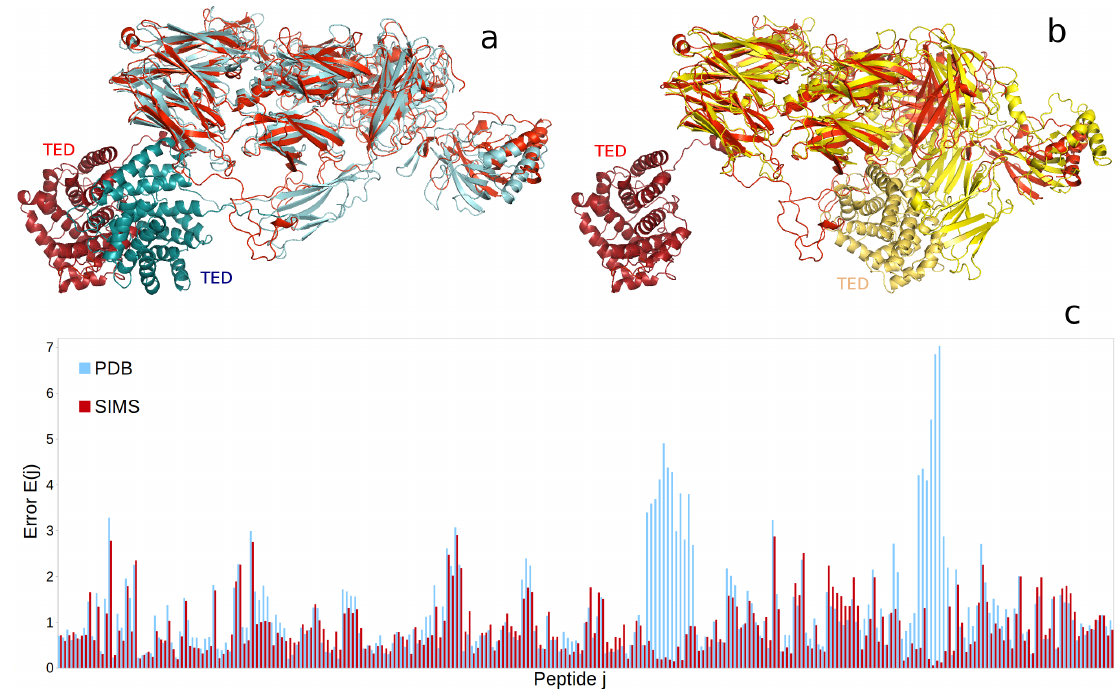
Figure 3. Uncovering the conformation of the complement protein iC3b. ( a ) Comparison between the conformation of iC3b produced by SIMS (colored red) and the hypothetical model built using the crystal structure of C3b reported in the PDB (ID 2I07, colored blue). In both conformations, the thioester-containing domain (TED), at the bottom left (colored in darker shades), is far from the protein’s core, ( b ) The conformation of C3 (PDB ID 2A73, colored yellow) is more compact, and the TED (colored dark yellow) is close to the protein’s core. ( c ) Differences between structurally-derived and experimental hydrogen-exchange data (unitless error E ( j ) , for each peptide j ) are significantly lower when these data are derived from the conformation of iC3b produced by SIMS (colored red) than when they are derived from iC3b’s hypothetical model (colored